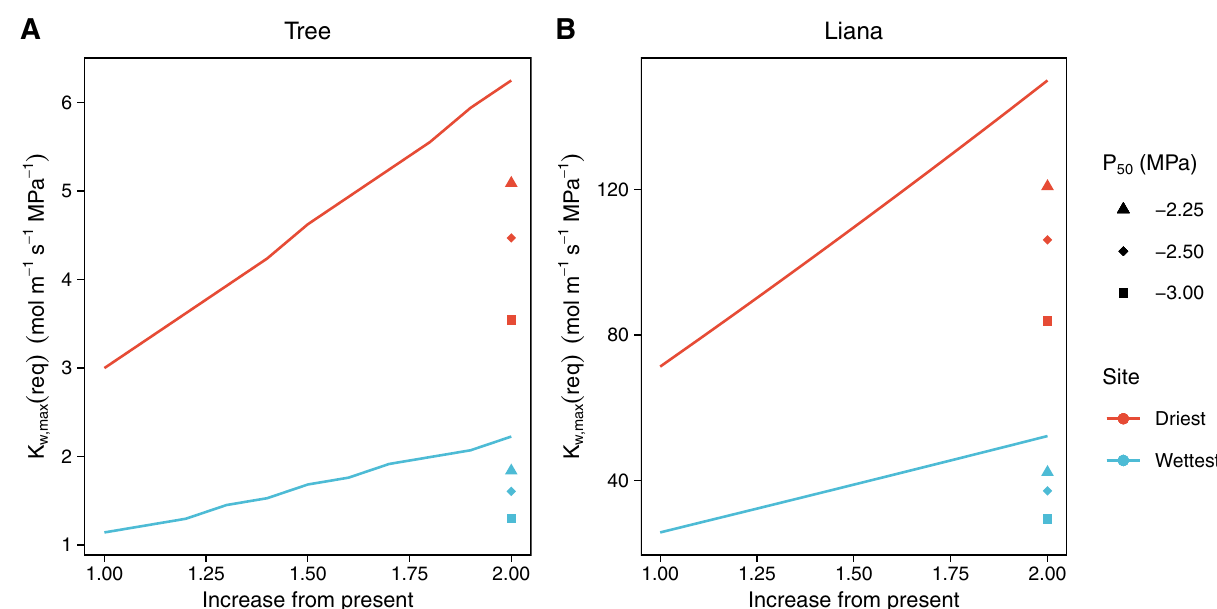
Fig. 5 Effect of P 50 parameter value on projections of future required maximum whole-plant hydraulic conductivity (K w,max (req)). Change in K w,max (req) as vapor pressure de fi cit (VPD) increases according to future projections for Central America. The x -axis is a multiplier of increase from the present. For example, 2.00 means VPD is doubled from the current hourly values for each month. The lines represent K w,max (req) under potential future VPD conditions spanning 1x to 2x current VPD at the dry forest site, Horizontes, Costa Rica (red) and the moist forest site, Barro Colorado Island, Panama (BCI, blue). A tree K w,max (req), B liana K w,max (req). Symbols at 2.00 on the x -axis of each panel represent K w,max (req) under various conditions of P 50 adaptation when VPD is doubled from present. Triangle: tree P 50 = liana P 50 = − 2.25 MPa; diamond: tree P 50 = liana P 50 = − 2.5 MPa; square: tree P 50 = liana P 50 = − 3.0